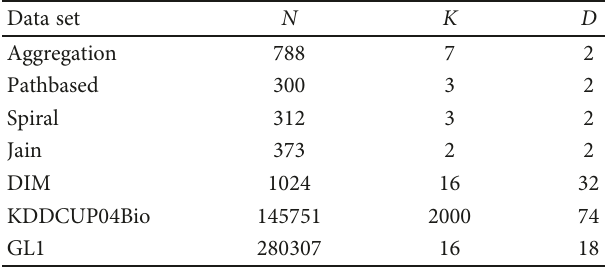
Table 1: The parameters of experiment data set.